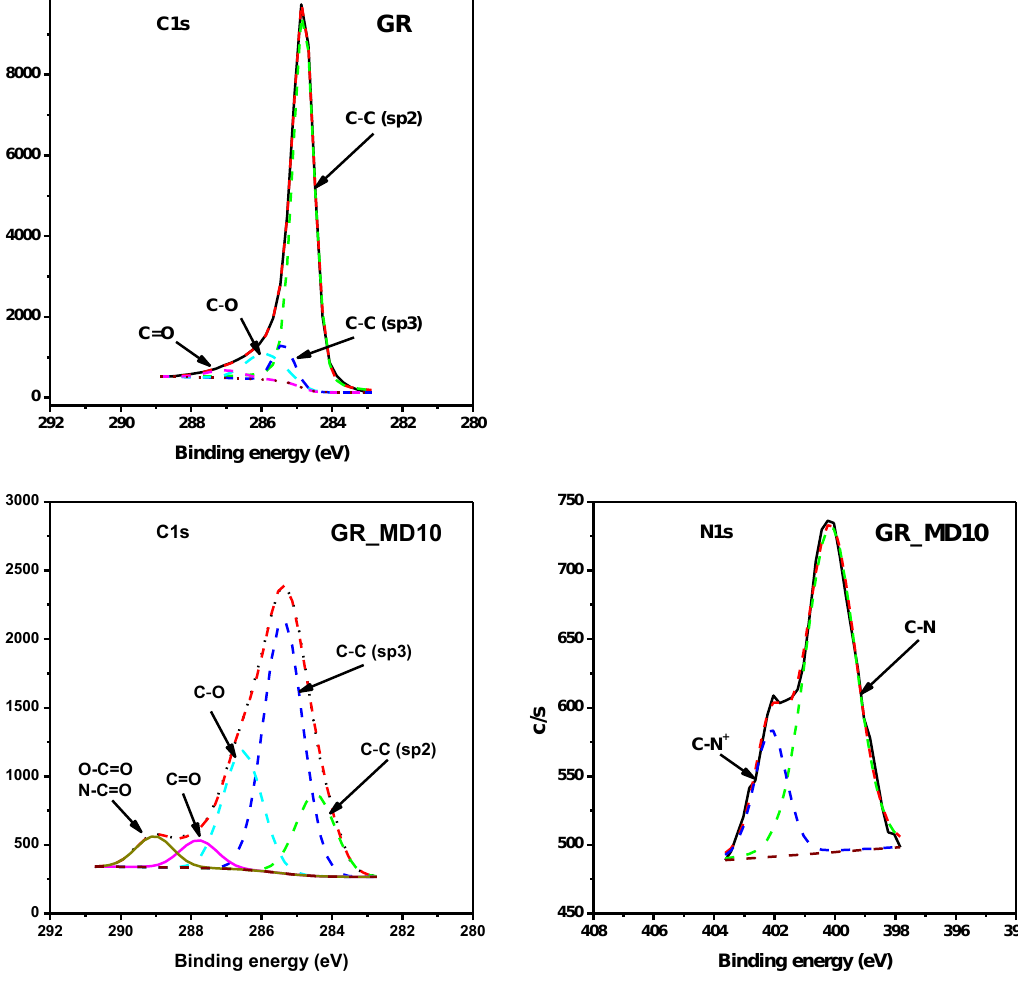
Figure 6. C1s and N1s XPS spectra of GO and GO_MD10.